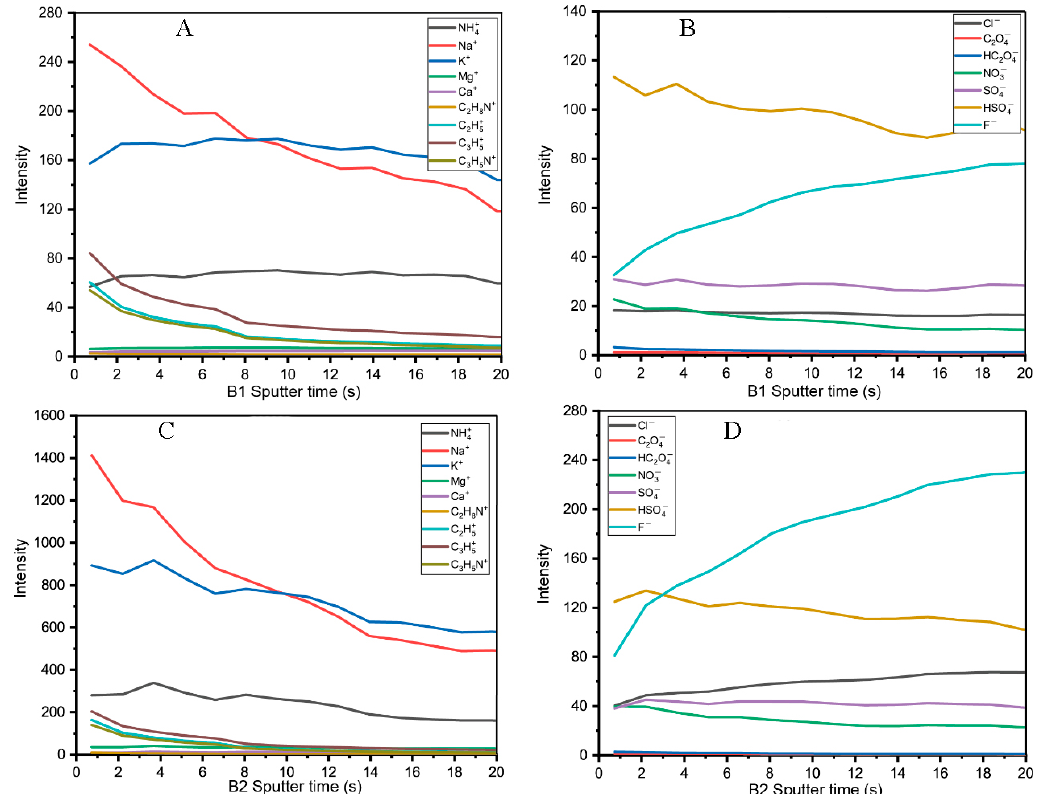
Figure 5. Depth profiles for PM 2.5 samples from FPH in winter. Note: ( A , B ) refer to Positive and Negative ions in samples A3, ( C , D ) refer to Positive and Negative ions in samples A4.